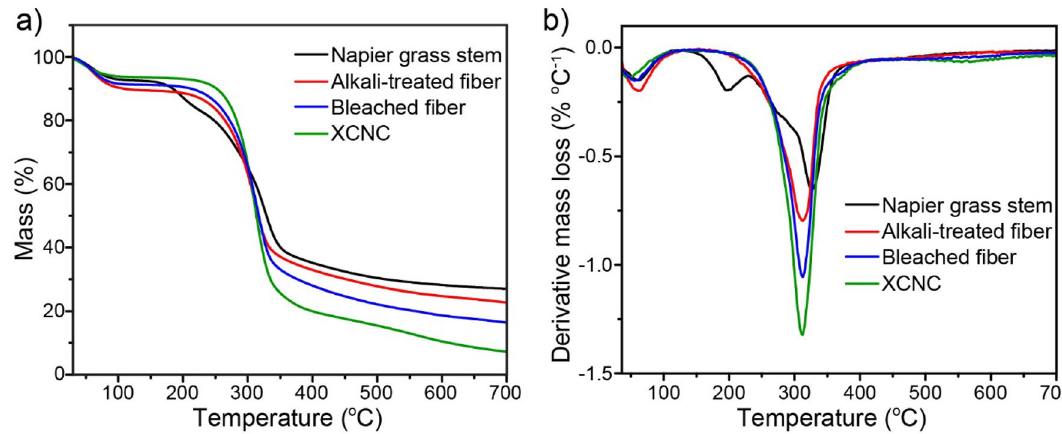
Figure 4. TGA results of the samples after each preparation process; ( a ) TG curves and ( b ) DTG